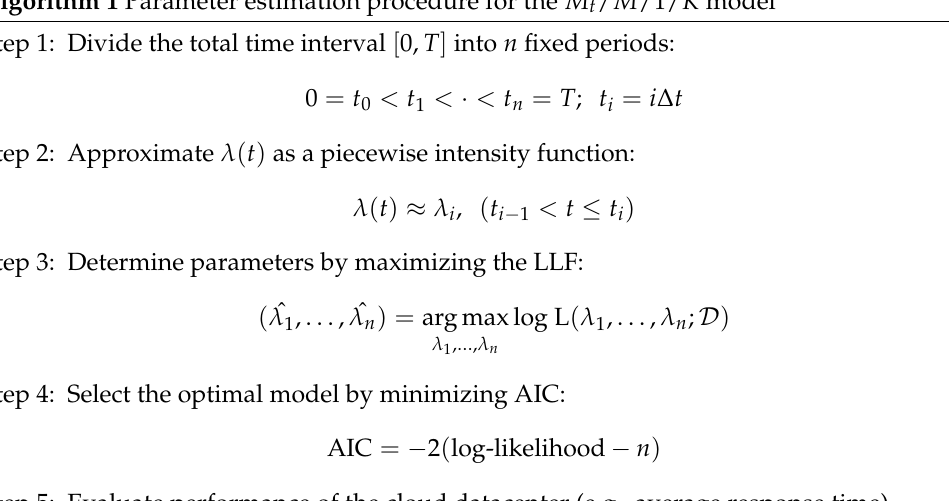
Algorithm 1 Parameter estimation procedure for the M t / M /1/ K